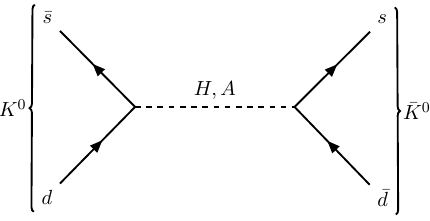
Figure 8 . Feynman diagram for the contribution from the new scalars H and A to K 0 −